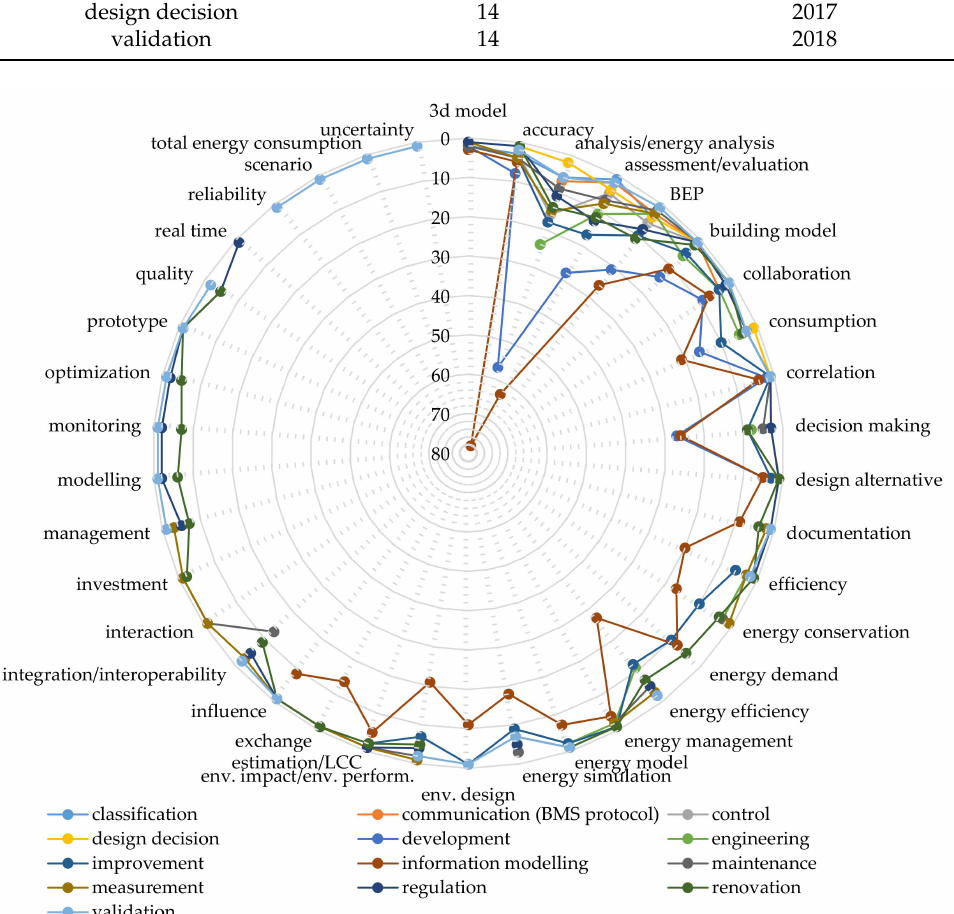
Figure 7. The activity–use case co-occurrence matrix in BIM and building energy efficiency analysis. Note: values of keywords co-occurrence are presented in reverse order to improve